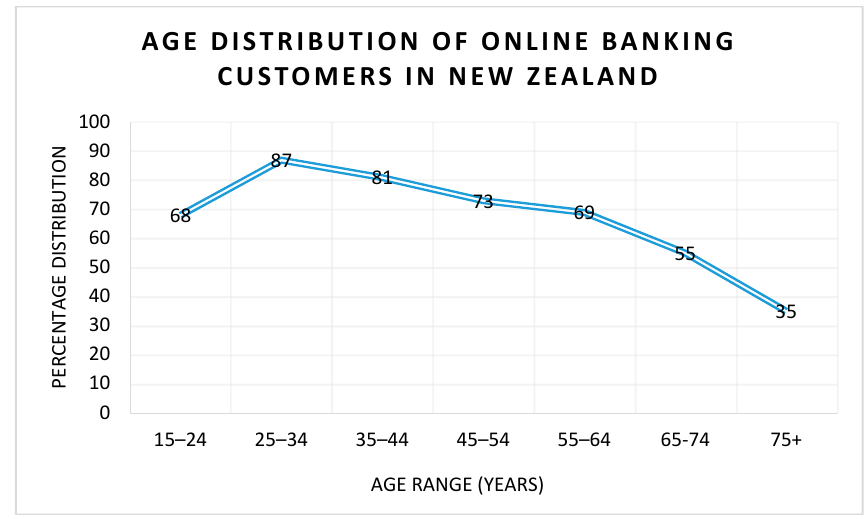
Figure 5. Age distribution of online banking customers in New Zealand (Data from [12]).